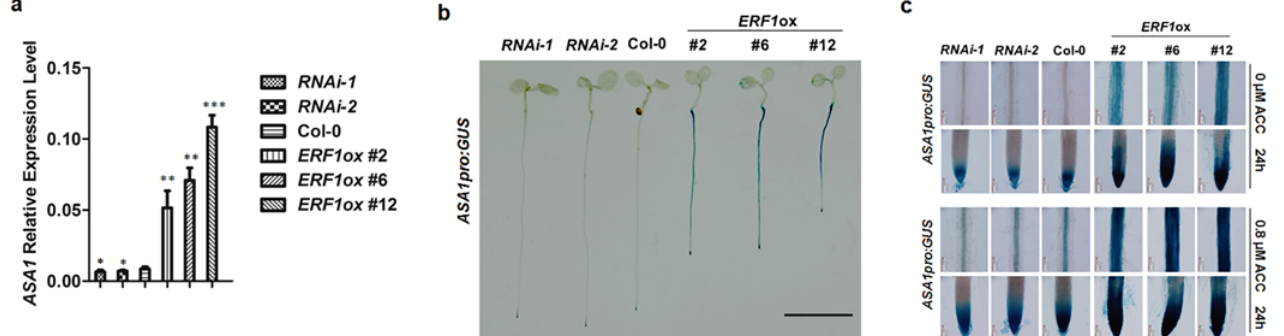
Fig 5. ERF1 up-regulates the expression of ASA1 in roots. ( a ) Transcript levels of ASA1 in 5-day-old Col-0, ERF1 knockdown ( RNAi-1 , RNAi-2 ), and overexpression ( ERF1ox # 2 , ERF1ox # 6 , ERF1ox # 12 ) seedlings. Values are mean ± SD of three replicas ( * P < 0.05, ** P < 0.01, *** P < 0.001). Asterisks indicate Student ’ s t-test significant differences. ( b ) ASA1 pro : GUS expression in 5-day-old Col-0 and ERF1 knockdown ( RNAi -1, RNAi -2) and over-expression ( ERF1ox # 2 , ERF1ox # 6 , ERF1ox # 12 ) seedlings. Three independent experiments were done, and each replica containing 15 plants for each genotype. Representative seedlings were photographed. Scale bar, 0.5 cm. ( c ) ASA1 pro : GUS expression in primary root maturation region and root tip of 5-day-old Col- 0, ERF1 knockdown ( RNAi-1 , RNAi-2 ), and overexpression ( ERF1ox # 2 , ERF1ox # 6 , ERF1ox # 12 ) seedlings without or with ACC treatment. More than 20 plants were observed for each genotype. Representative photos were displayed.